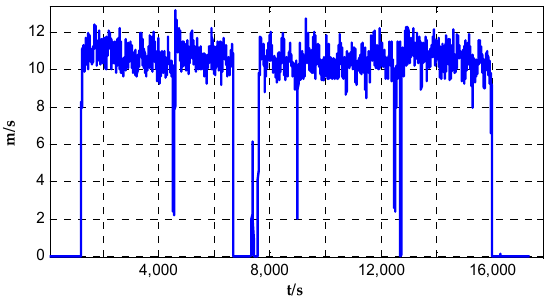
Figure 4. Profile of raw velocity output by S-350 velometer.